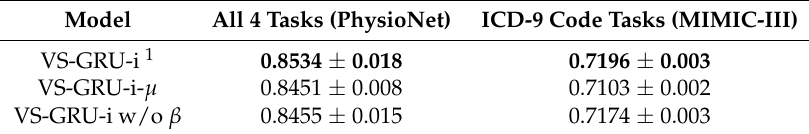
Table 5. Comparison on the missing factor in